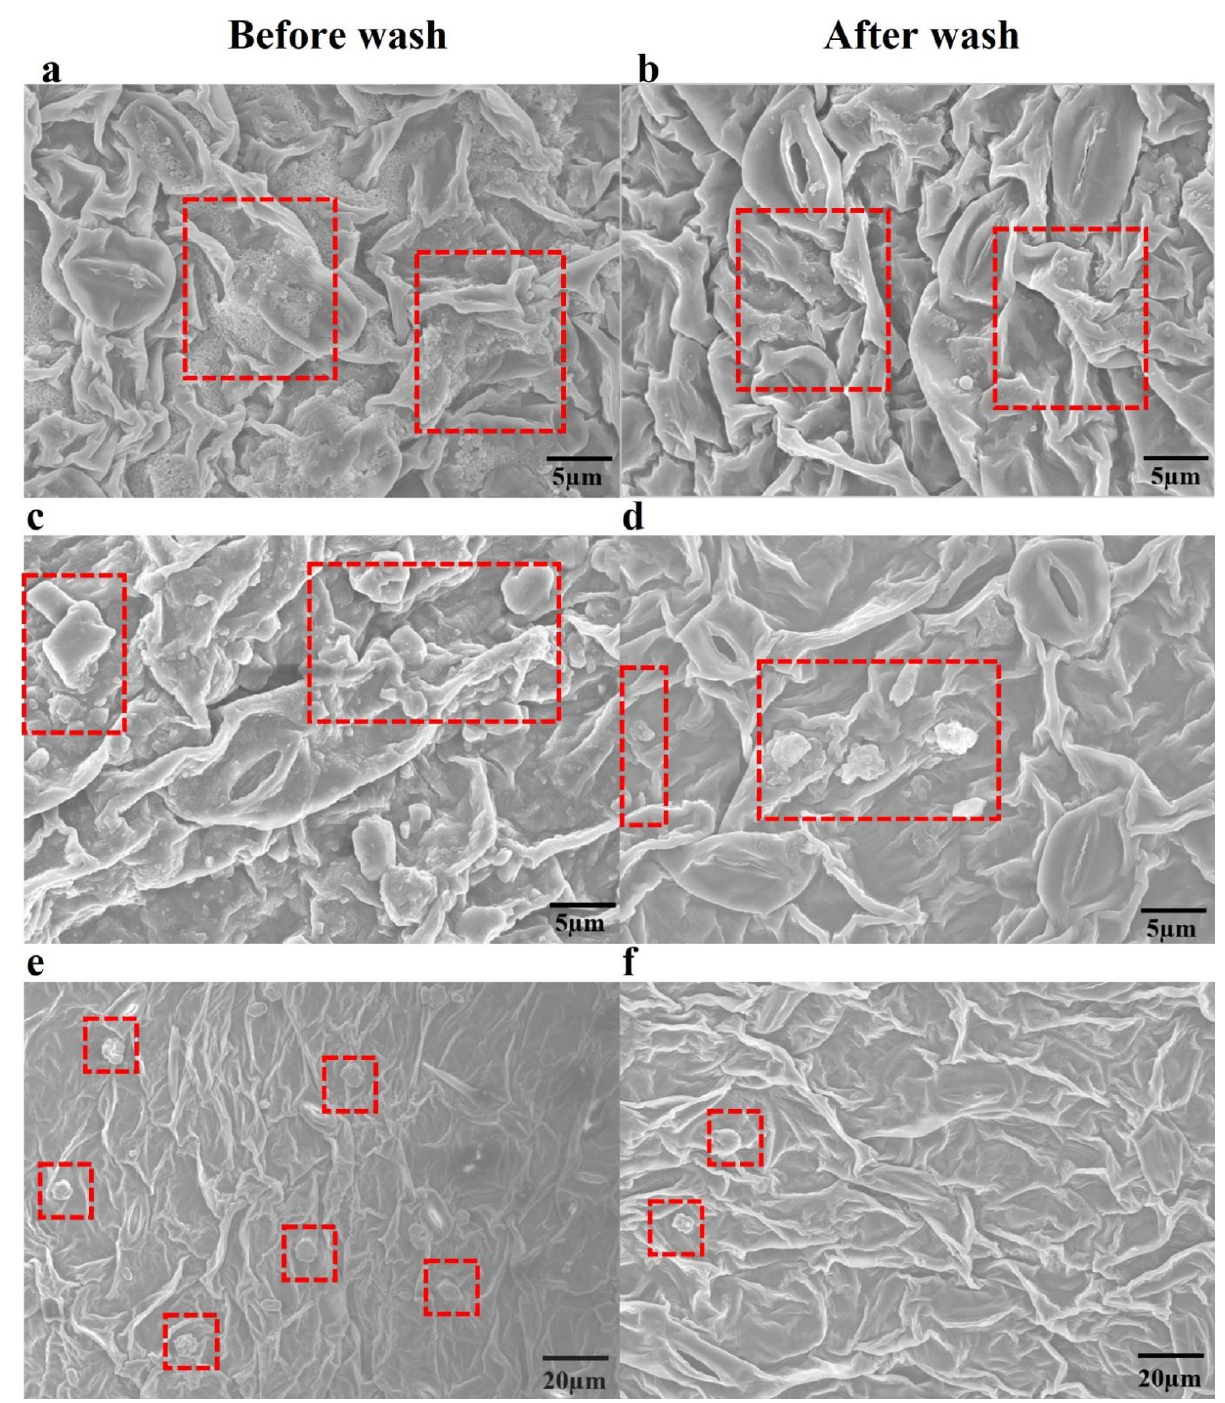
Figure 11. SEM images on cucumber leaves. ( a ) Image with nano-microcapsules, ( c ) image with WDG-Chl, ( e ) image with WDG-LC. ( b , d , f ) are the corresponding images after wash. The scale bar is 5 µm for ( a – d ) and 20 µm for ( d , e ).